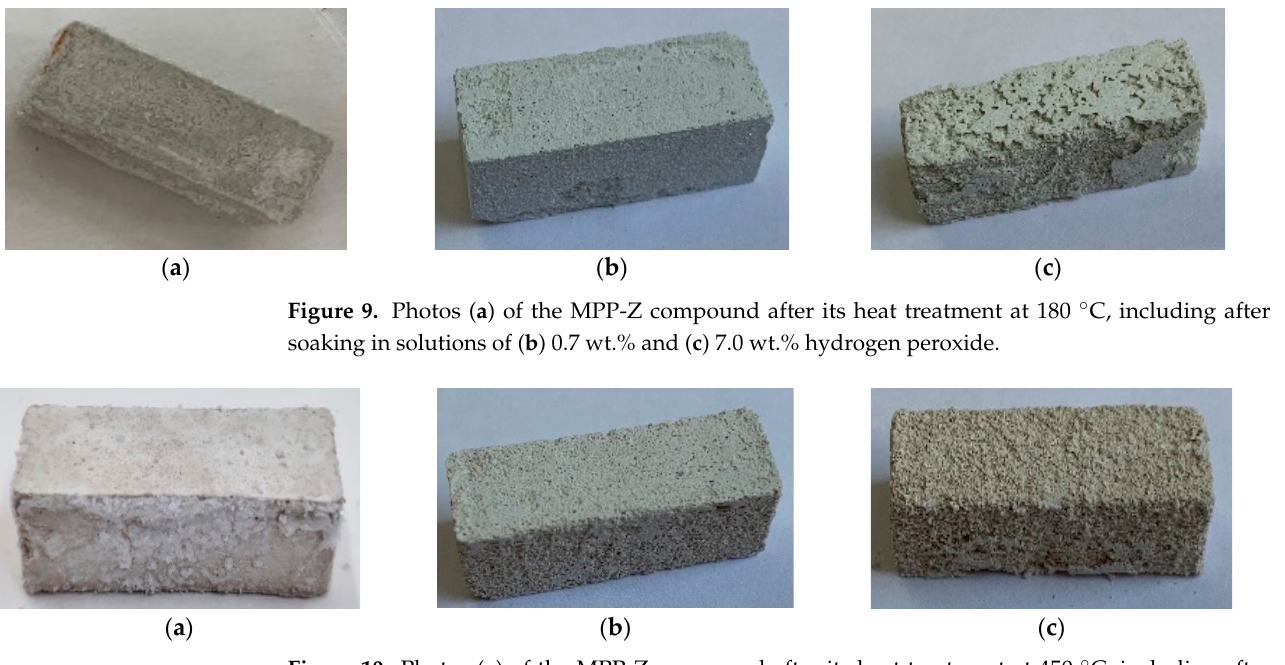
Figure 10. Photos ( a ) of the MPP-Z compound after its heat treatment at 450 °C, including after soaking in solutions of ( b ) 0.7 wt.% and ( c ) 7.0 wt.% hydrogen peroxide.